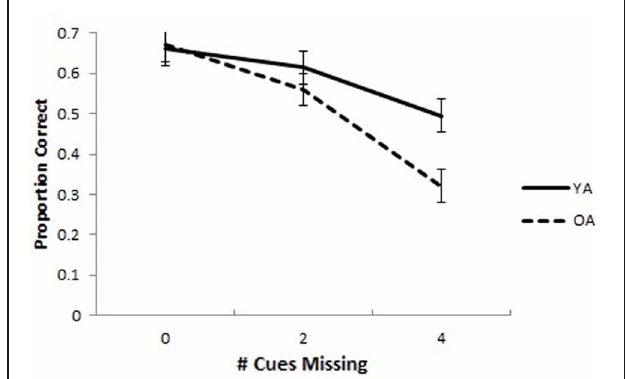
FIGURE 2 | Spatial pattern completion in younger and older adults controlling for baseline associative memory performance. Older adults performed worse overall compared to young adults on a pattern completion task. Older adults performed similarly to young adults when 0 extra-maze cues were missing, but worse when 2 or 4 cues were missing. Error bars show the standard error of the